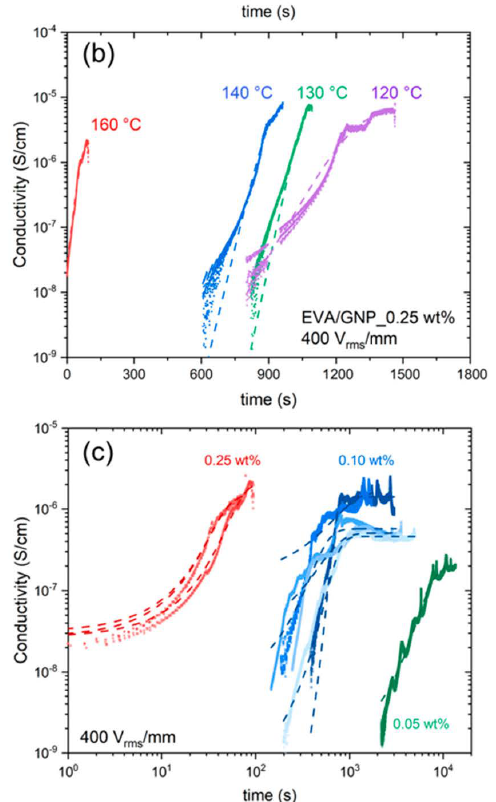
Figure 4. Time-resolved electrical conductivity of EVA/GNP composites during electric field appli- cation. ( a ) GNP concentration fixed at 0.25 wt% with varying electric field strength (400 V rms /mm or 250 V rms /mm) at 160 ◦ C. ( b ) Field strength fixed at 400 V rms /mm with varying temperature (120–160 ◦ C) to control composite melt viscosity. ( c ) Field strength fixed at 400 V rms /mm with vary- ing GNP concentrations (0.25, 0.10, or 0.05 wt%) at 160 ◦ C; dashed line, fitting with the logistic growth model given by Equation (5).